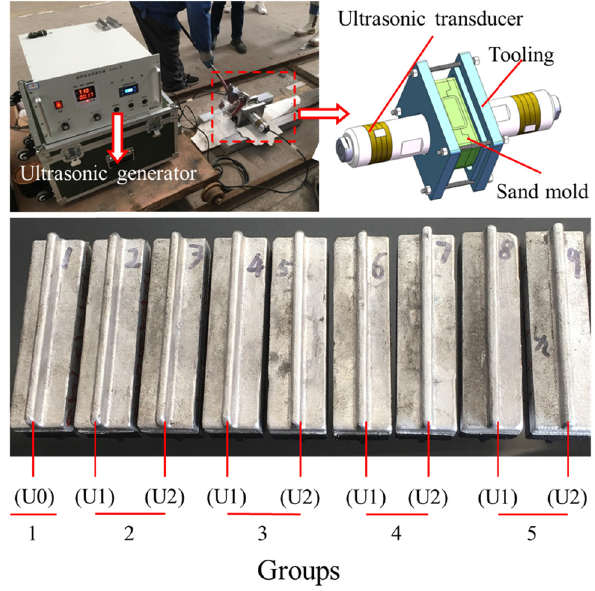
Figure 1: Ultrasonic sand casting system and